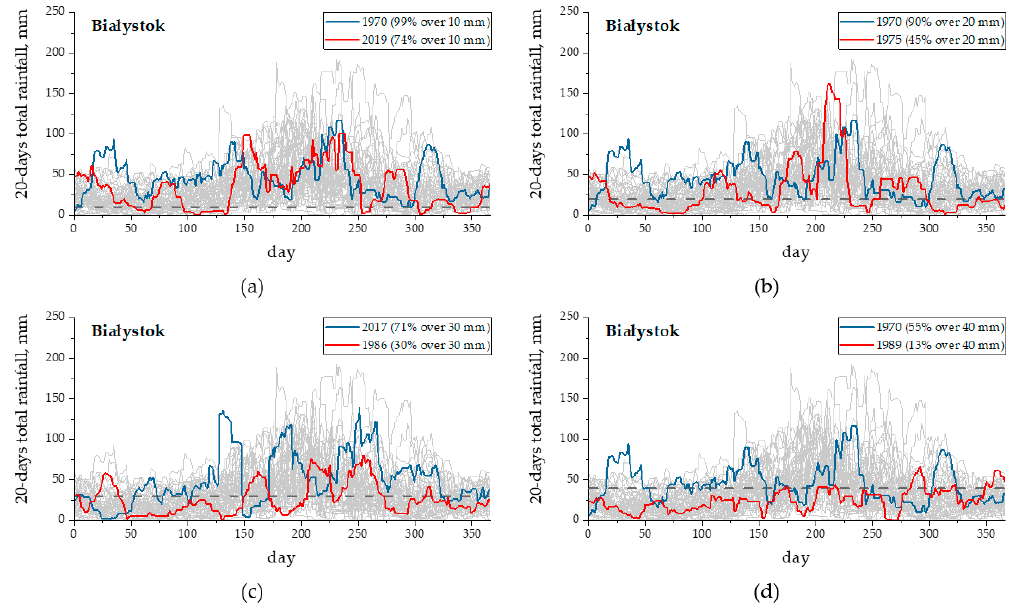
Figure 6. Twenty-day cumulative rainfall for Białystok (1970–2019) at threshold values ( a ) 10 mm, ( b ) 20 mm, ( c ) 30 mm and ( d ) 40 mm.